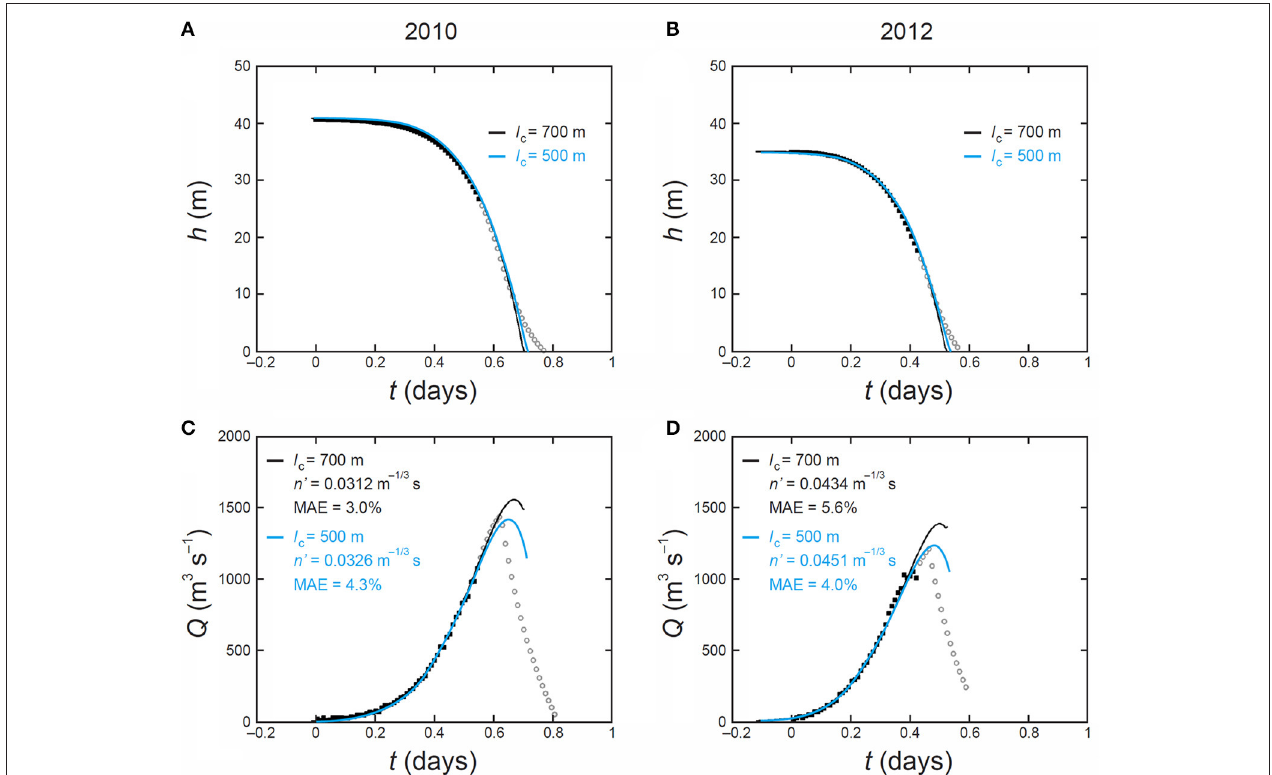
FIGURE 5 | Best-fit simulated lake level histories (A,B) and flood hydrographs (C,D) for the 2010 and 2012 outbursts when l c (blue). Solid squares show measured data and gray circles reconstructed data. In all panels, the time axis t places the first measured data point used in the hydrograph-fitting exercise at t 0. In (C,D), the mean absolute error (MAE) of misfit between model and measured data and the optimal Manning roughness n’ are =